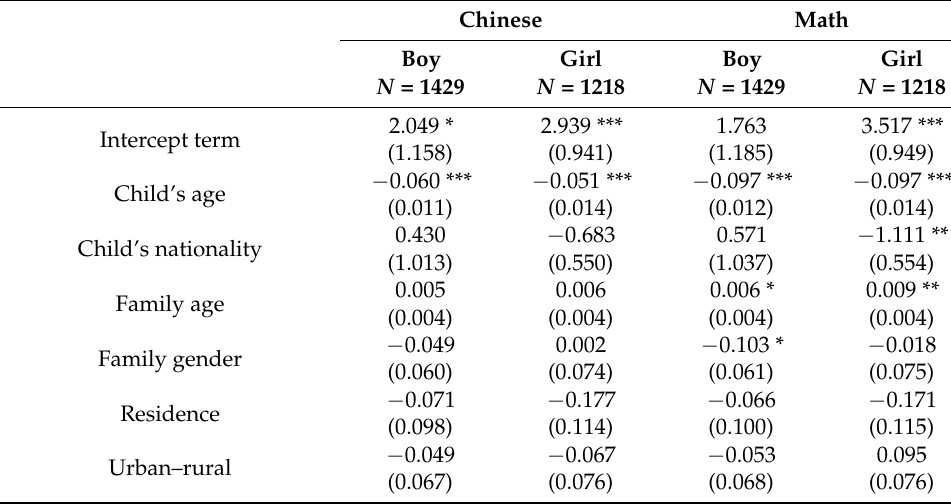
Table A2. Results for two-stage least squares by